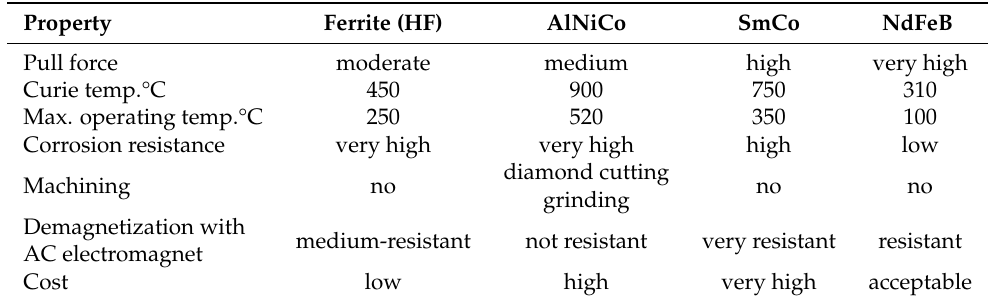
Table 1. Permanent magnet